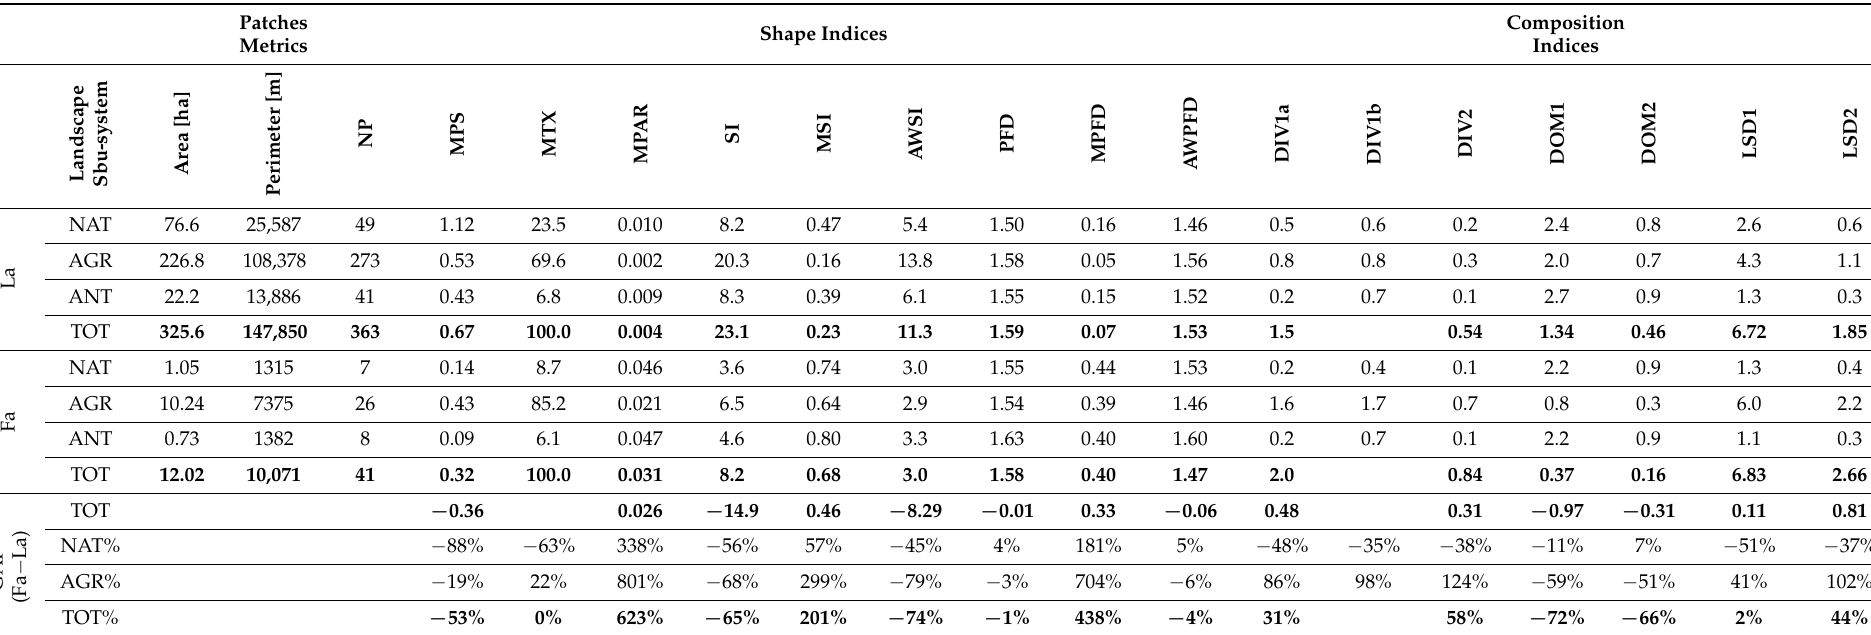
Table 2. Results on landscape structural indicators [Shape Indices (NP: number of patches; MPS: Medium patches size; MTX: Matrix; MPAR: Mean Perimeter area ratio; SI: Shape index; MSI: Mean Shape index; AWSI: Area weighted mean shape index; PFD: Patch fractal dimension; MPFD: Mean patch fractal dimension; and AWPFD: Area weighted mean patch fractal dimension) and Composition Indices (DIV1a: Diversity_1a/tot; DIV1b: Diversity_1b/landscape element; DIV2: Diversity_2; DOM1: Dominance_1; DOM2: Dominance_2; LSD1: Landscape Structural Diversity_1; LSD2: Landscape Structural Diversity_2)], comparing local ( La ) and farm ( Fa ) scale levels of analysis, respectively for the natural (NAT), agricultural (AGR), and anthropic (ANT) landscape sub-systems and for the total landscape system (TOT) (in bold), for which the difference between Fa and La is shown (GAP) (see Appendix A; Table A1 for details on the studied